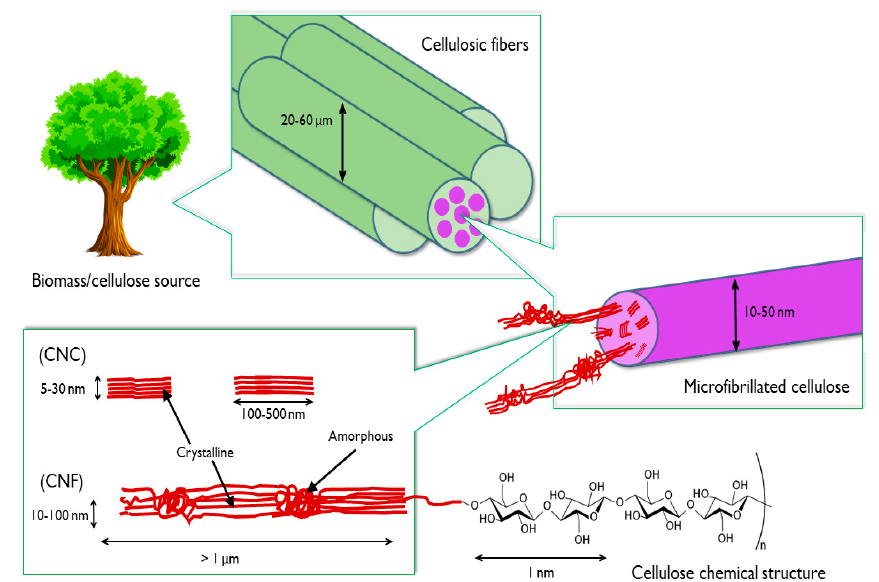
Figure 1. Schematic representation of nanocellulose showing the hierarchical structure.